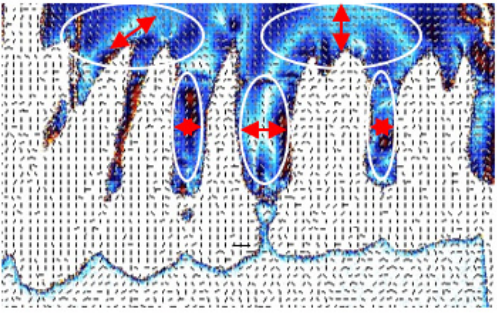
Figure 11. The average tendency of the stress direction in all six combinations. The stress direction of all combinations showed the same tendency, as follows: oblique in the anterior teeth root apex, horizontal at inter root space between the premolars and molars, and vertical in the apical area of the molars.